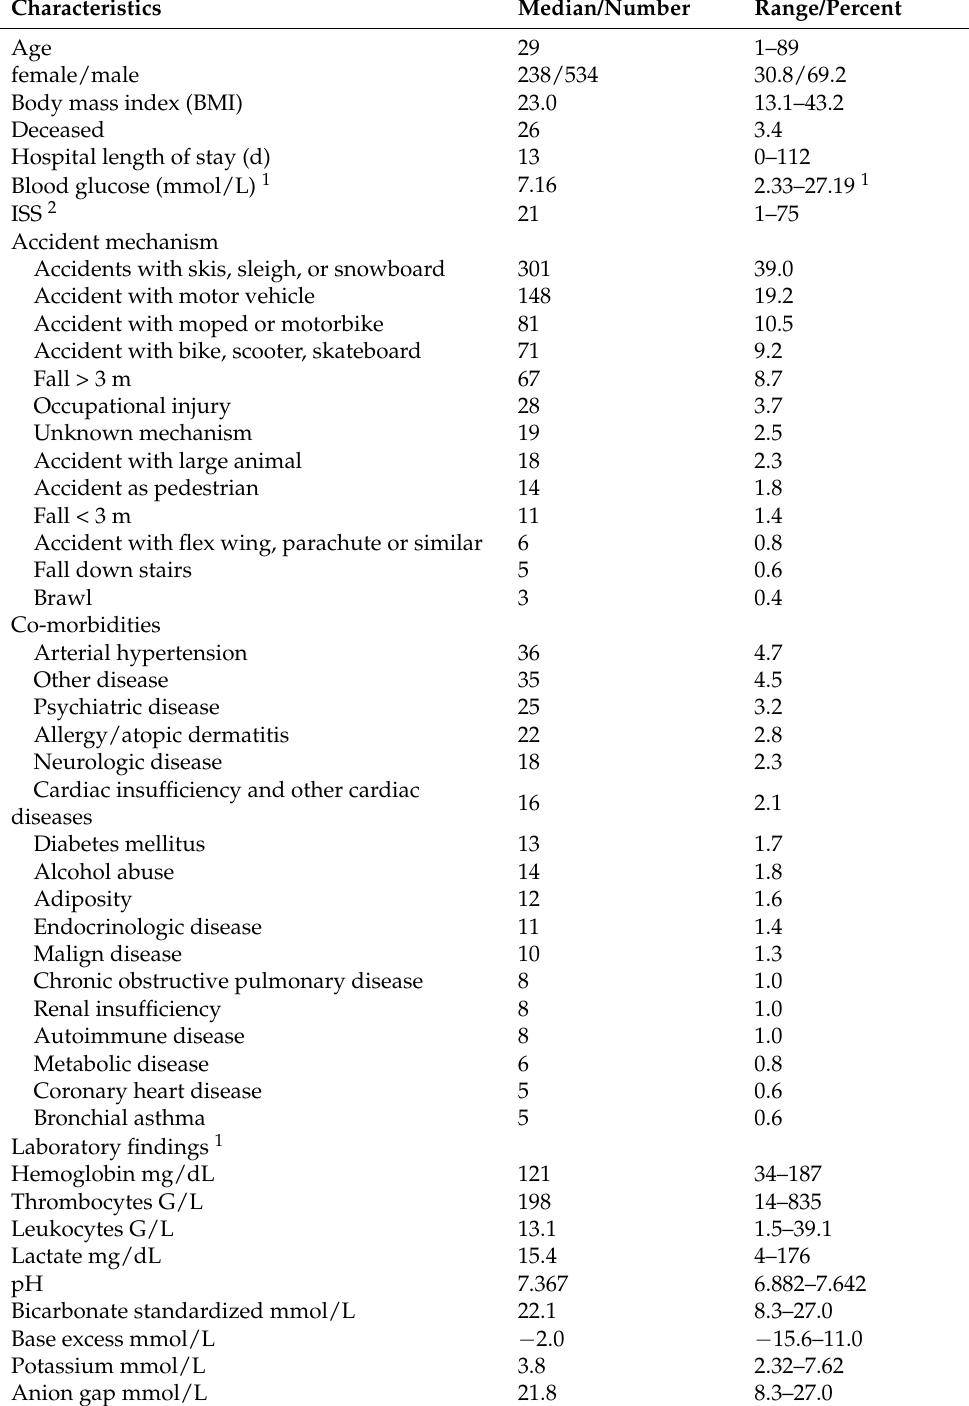
Table 2. Study population characteristics, n =